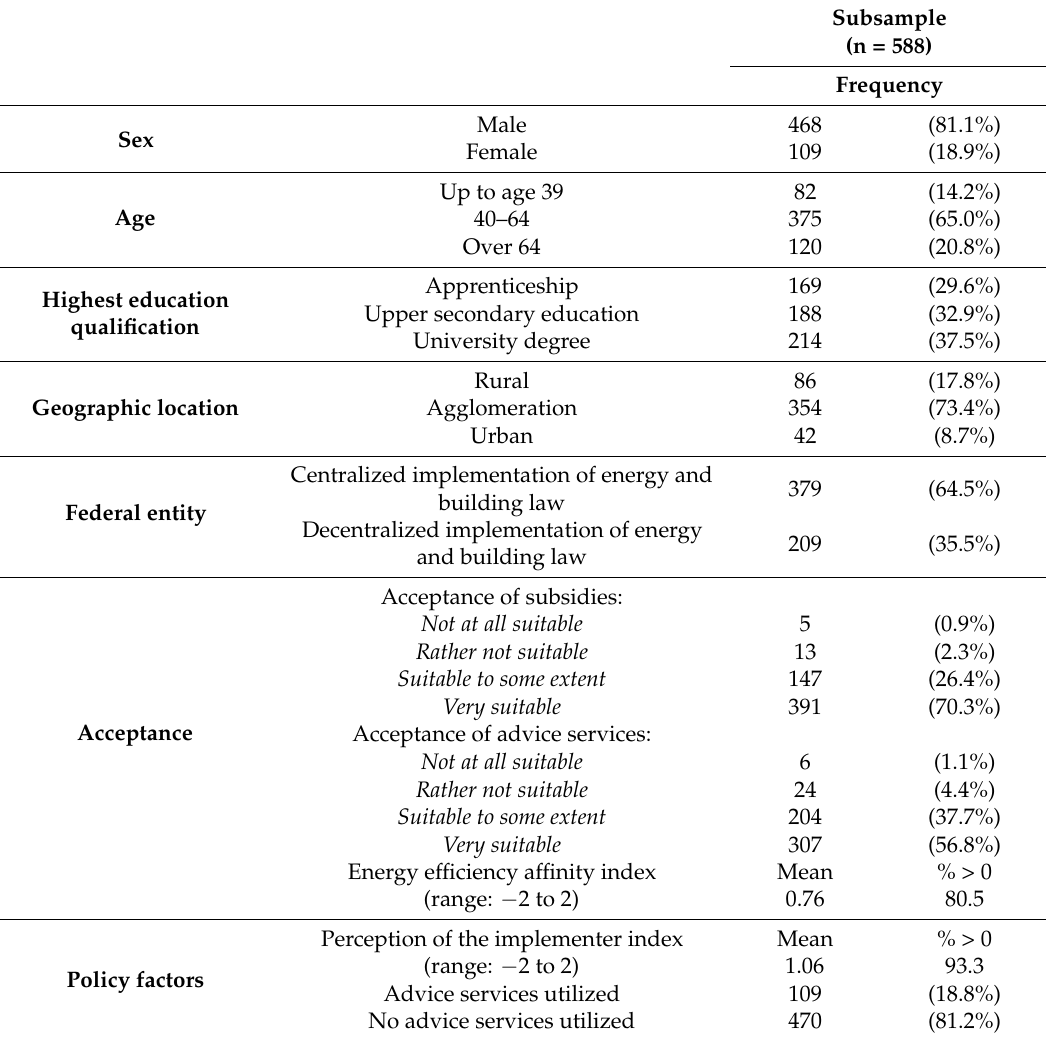
Table 1. Description of the sample of recipients of